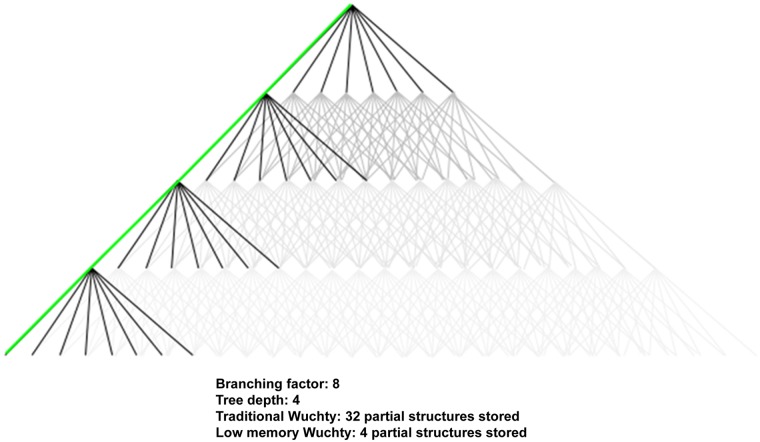
Tree Structure of Wuchty and Low Memory.The lines connect the point between a parent state and a child state and abstractly represent the tree structure of the Wuchty algorithm. The points at the bottom are leaves of the tree and represent a completely computed RNA secondary structure. The dark lines highlight the parts of the tree that are stored in memory during the computation of the first structure by the original Wuchty algorithm. The green line highlights the parts of the tree stored in memory by our ‘low memory’ modification. “Only one leaf of the calculation for the complete tree (shown in gray) is highlighted for clarity in this example.